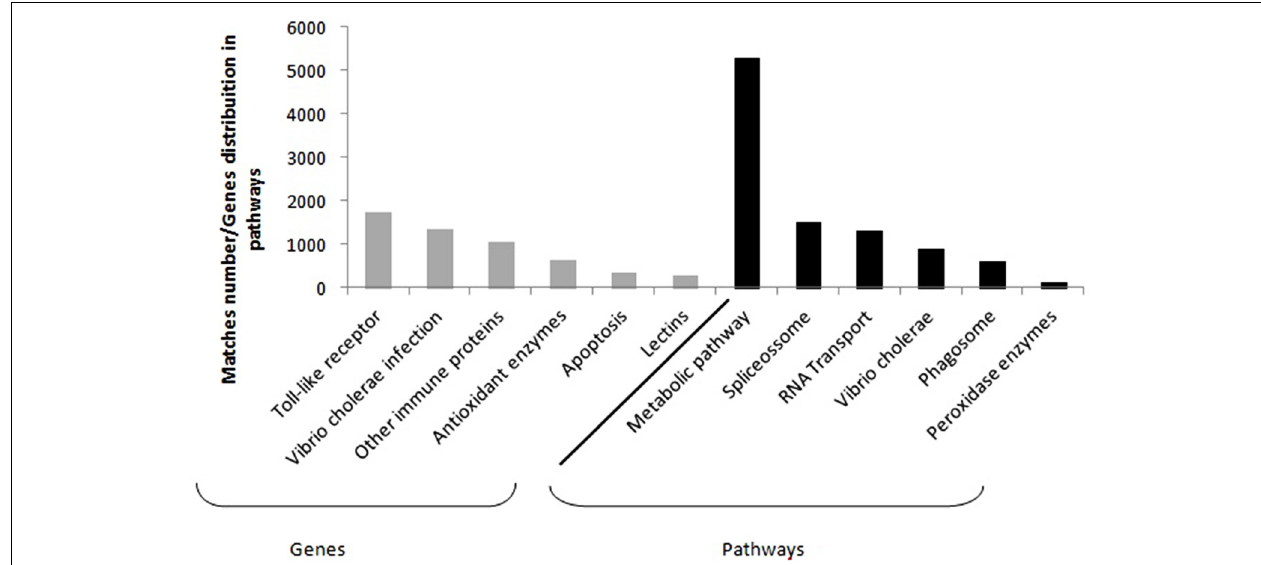
FIGURE 1 | Compilation based on the immune genes in Supplementary Material available online from seven studies. Details from the study and the respective files are as follow: Li etal. (2012;Tables S5, S6 and S7), Li etal. (2013;Tables S3 and S6), Sookruksawong etal. (2013;Tables S5 and S6), Zeng